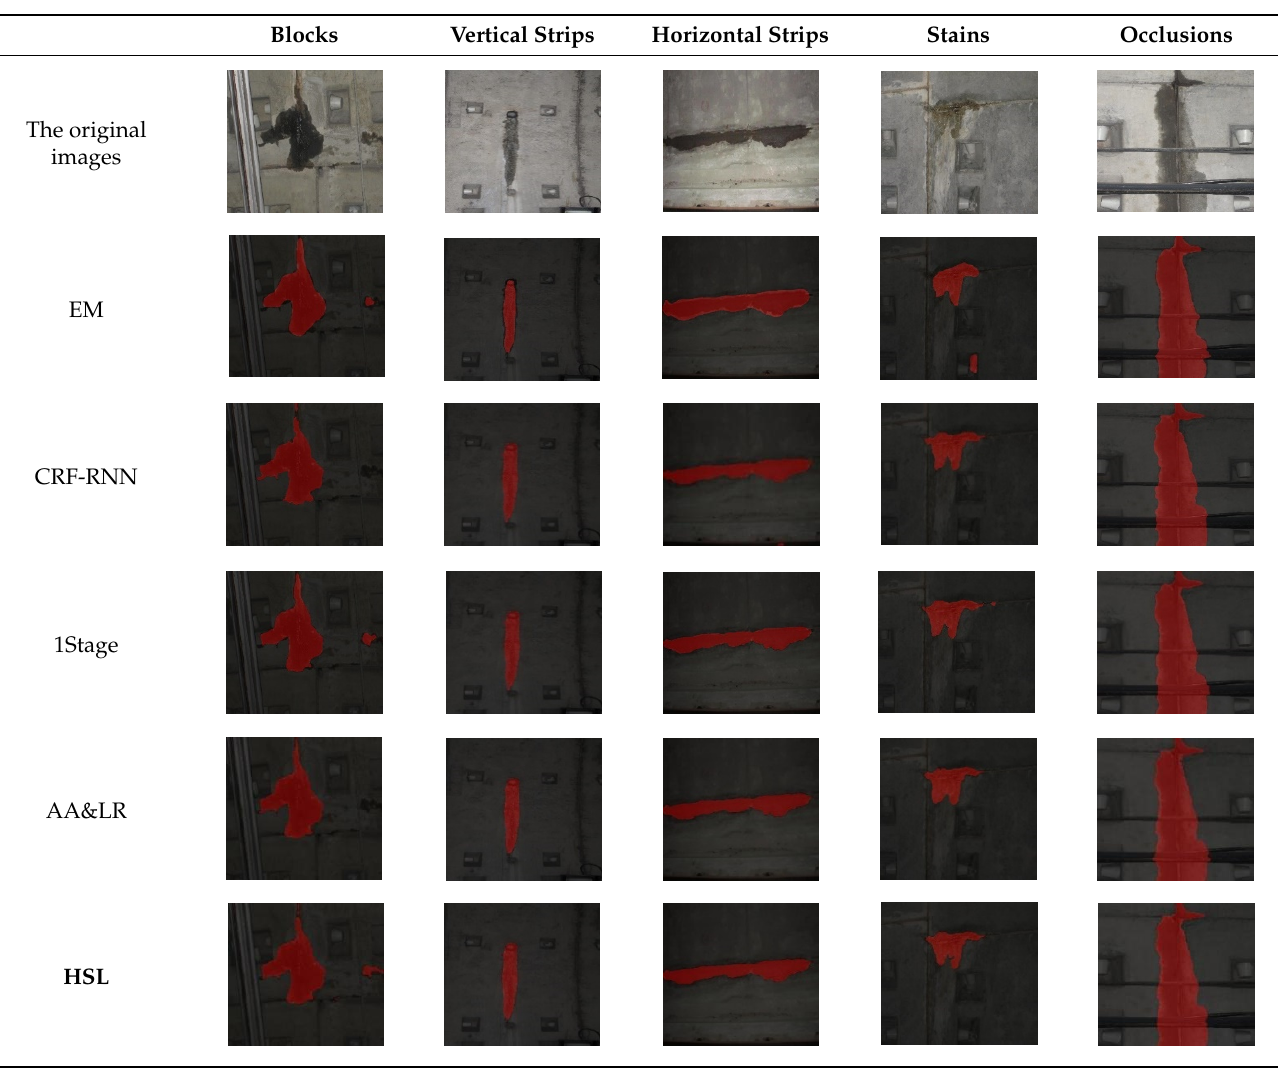
Table 8. Comparison of segmentation effects of HSL and the end-to-end semantic segmentation network under different water leakage types.